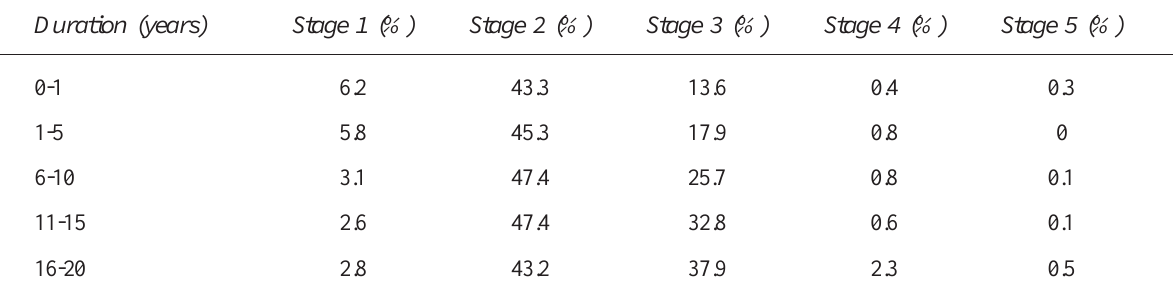
Table 2. CKD staging of patients who had nephropathy